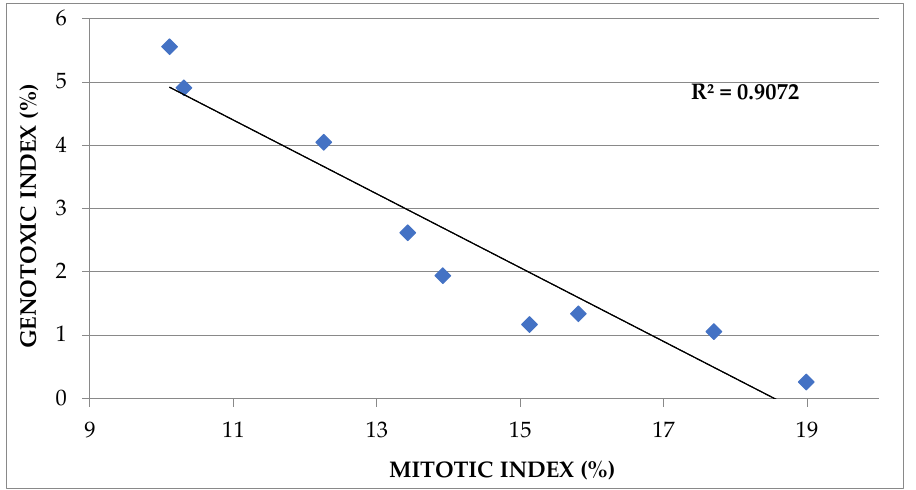
Figure 5. Correlation between the genotoxic index (%) and mitotic index (%) in wheat root meristem cells treated with non-thermal plasma-activated water. All the genetic abnormalities identified in the Triticum aestivum root meristems of the